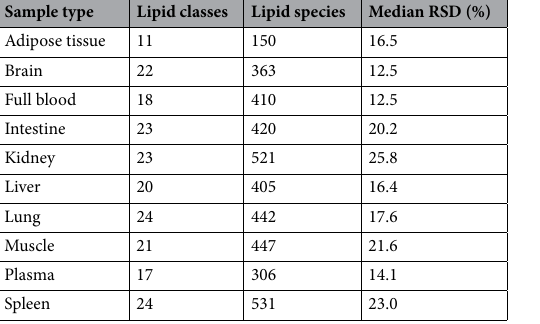
Table 1. Lipidome coverage and reproducibility of the measurements. Median RSD is provided for individual lipid (sub)species in the biological